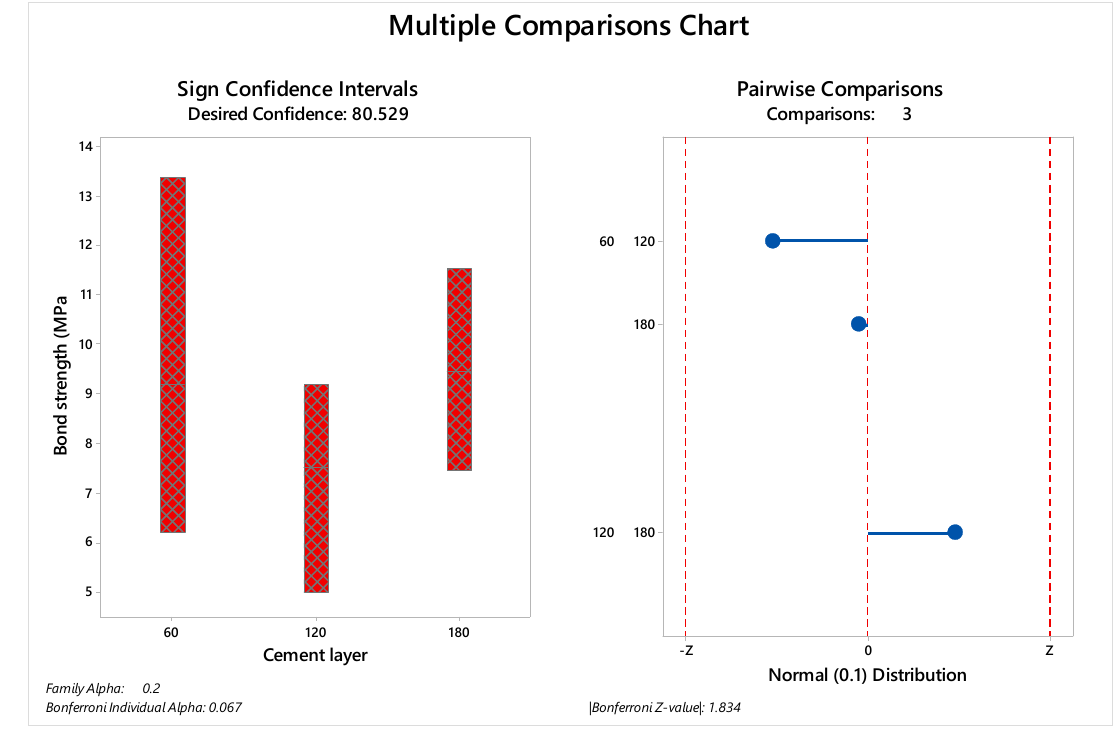
Figure 3. Multiple comparison chart for immediate tested groups (60, 120 and 180 μ m). The sign of confidence was calculated considering family alpha = 0.2 and Bonferroni individual alpha = 0.067. The pairwise comparison demonstrated 1.83 as the Bonferroni Z-value without a visible difference between the evaluated cement layers. Table 4. Confidence intervals, achieved confidence and data position according to the cement layer thickness for the immediate tested groups.